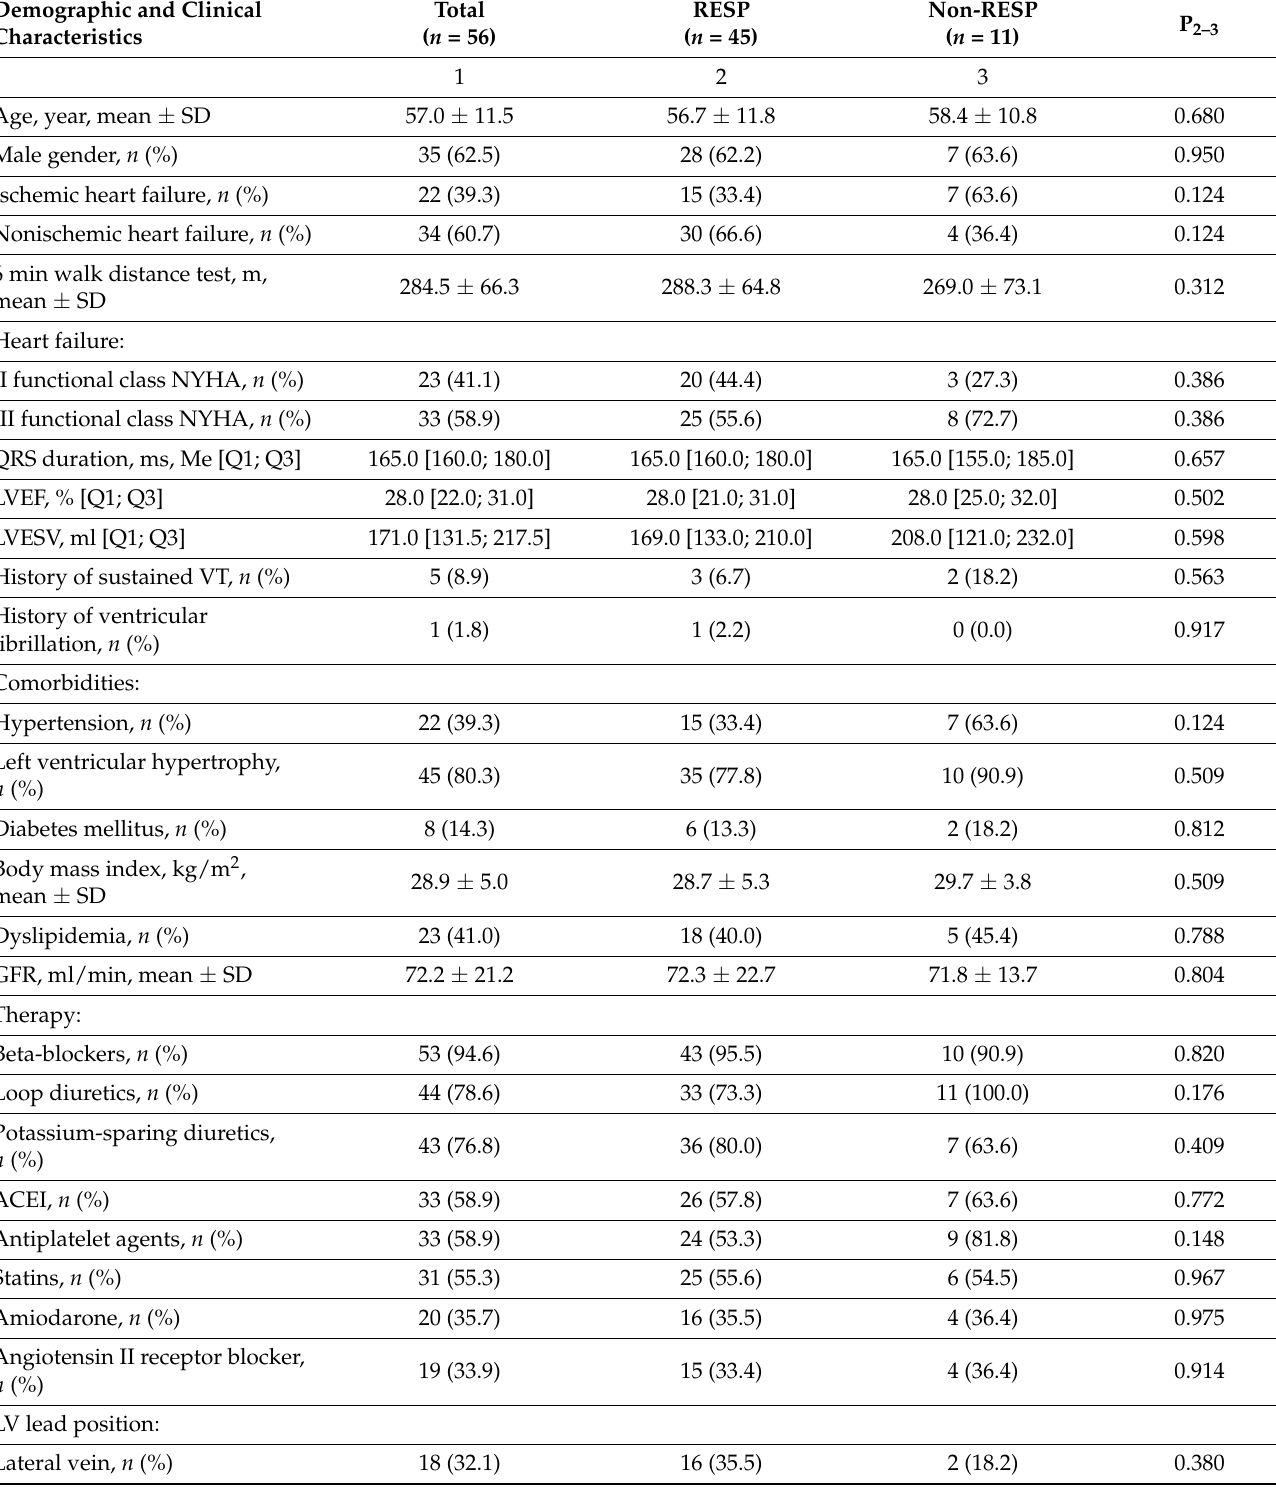
Table 1. Baseline demographics and clinical characteristics of enrolled